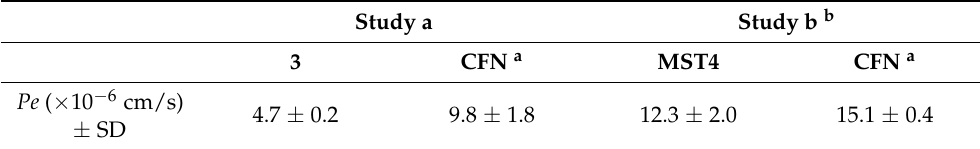
Table 4. Result of BBB penetration of compound 3 evaluated in PAMPA assay.